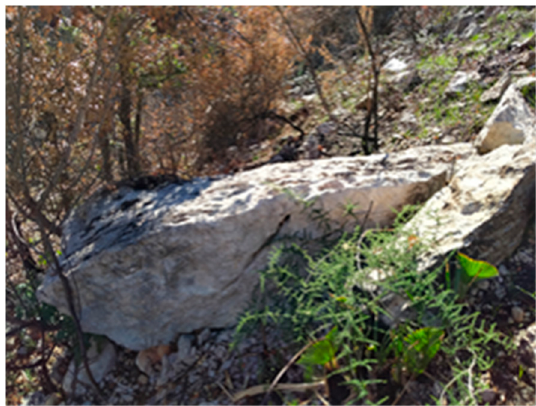
Figure 12. Sunset over this concavity during the winter solstice. The photo is taken by the author.